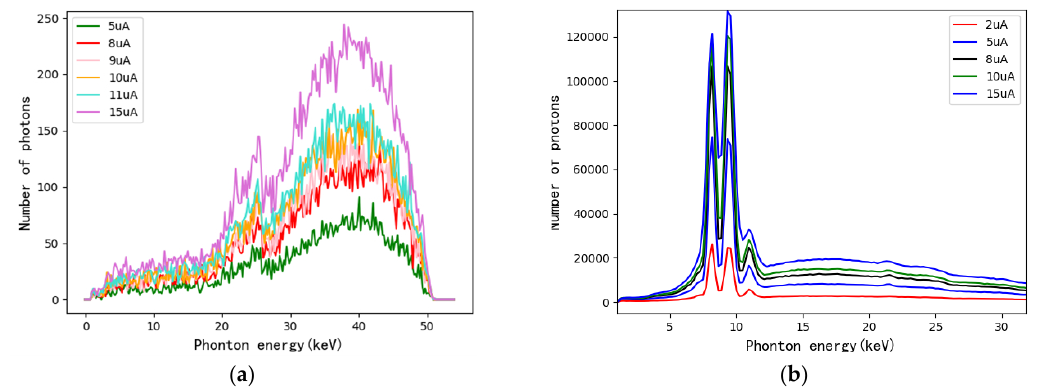
Figure 4. ( a ) Spectrum of specimen with maximum thickness ( b ) Spectrum of background.